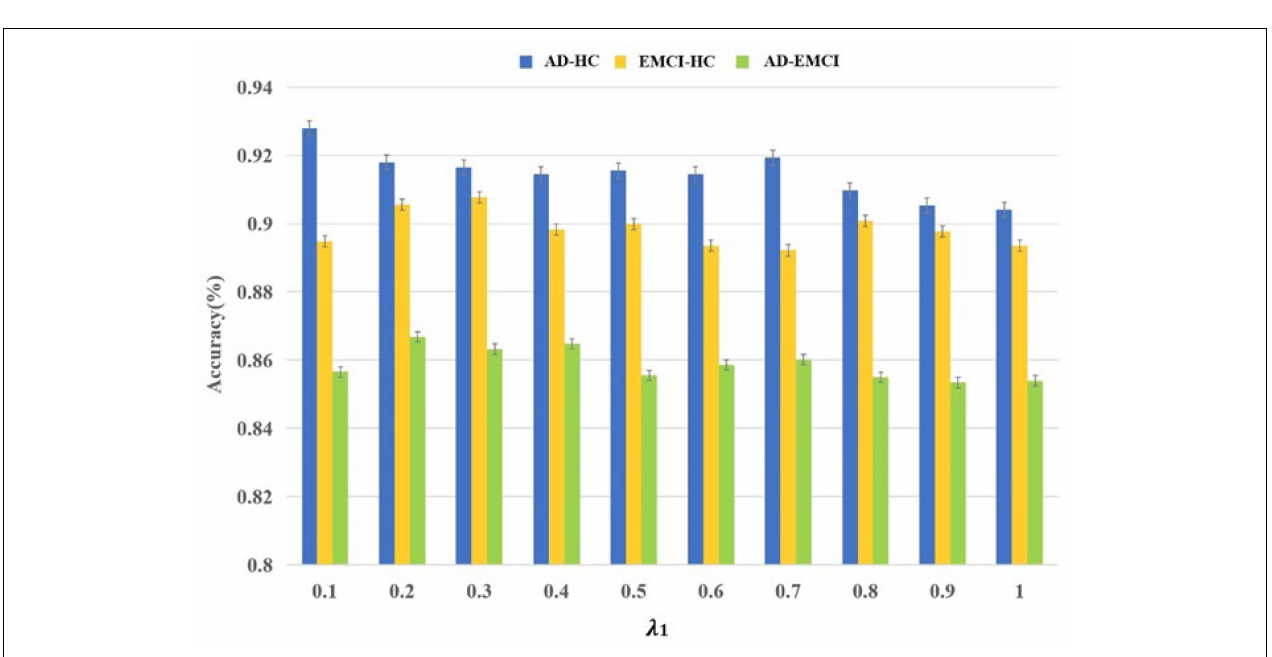
FIGURE 2 | The relationship between the accuracies and λ